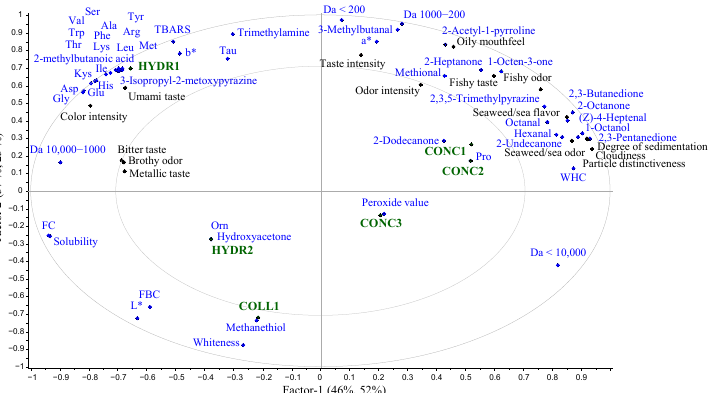
Figure 7. The Partial Least Squares (PLS) correlation loading of commercial fish protein concentrates, hydrolysates, and hydrolyzed collagen, where the free amino acids, lipid oxidation, peptide profile, odor-active volatile compounds identified with GC-MS-O, color, solubility, water holding capacity (WHC), fat binding capacity (FBC), and foaming capacity (FC) are the predictors (blue) of sensory properties (black). Fish protein concentrates = CONC1–3, fish protein hydrolysates = HYDR1–2, hydrolyzed fish collagen = COLL1.